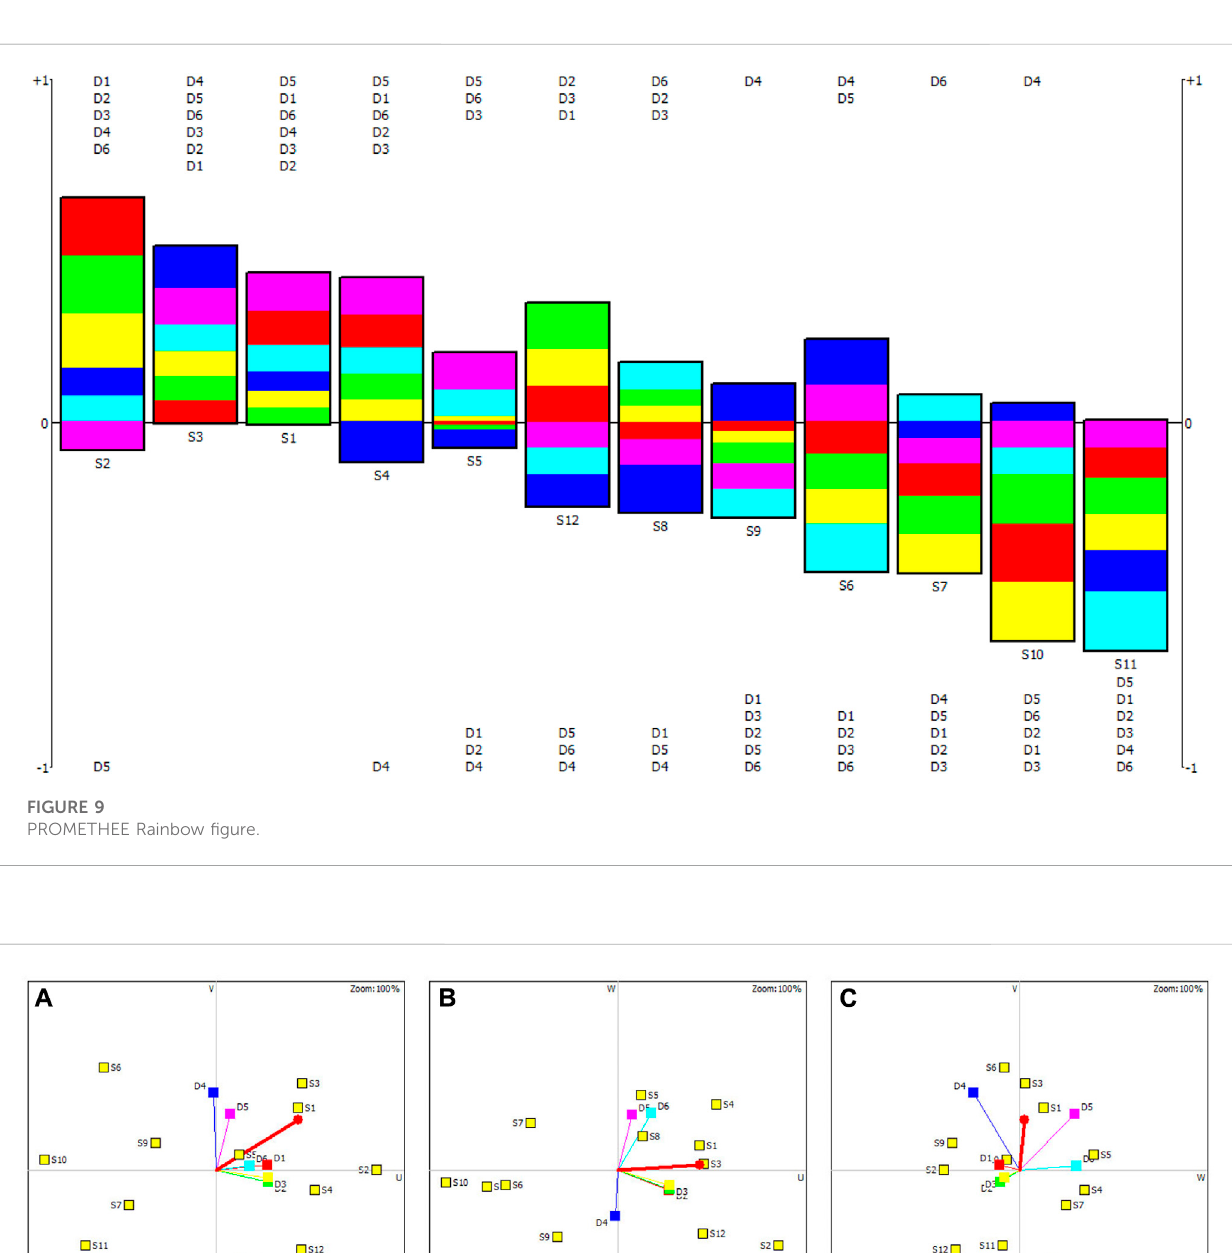
FIGURE 10 Interaction-assisted graphic: (A) U-V plane, (B) U-W plane, (C) W-V plane.